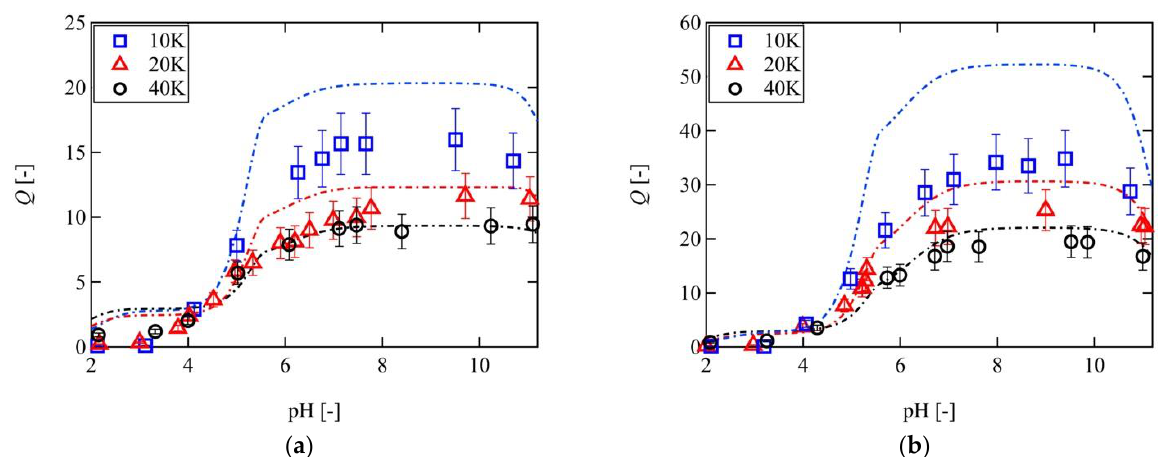
Figure 6. Comparison of the experimental results with the predictions made by the FRGDM model (dashed lines) at ionic strengths of ( a ) 10 mM, and ( b ) 2 mM for the 10 K (blue), 20 K (red), and 40 K (black) Tetra-PAA-PEG gels.